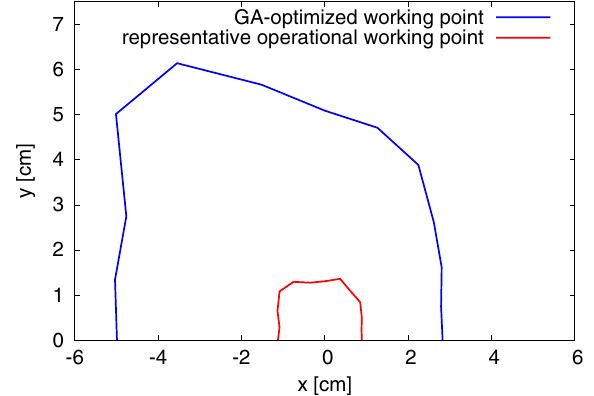
FIG. 11. Comparison of the dynamic aperture for the initial ð (cid:3) x ; (cid:3) y Þ ¼ ð 0 : 31 ; 0 : 32 Þ working point (red line) to that for the optimal (0.994, 0.001) working point marked with the blue (cid:5) ’s in Figs. 9 and 10 (blue line).